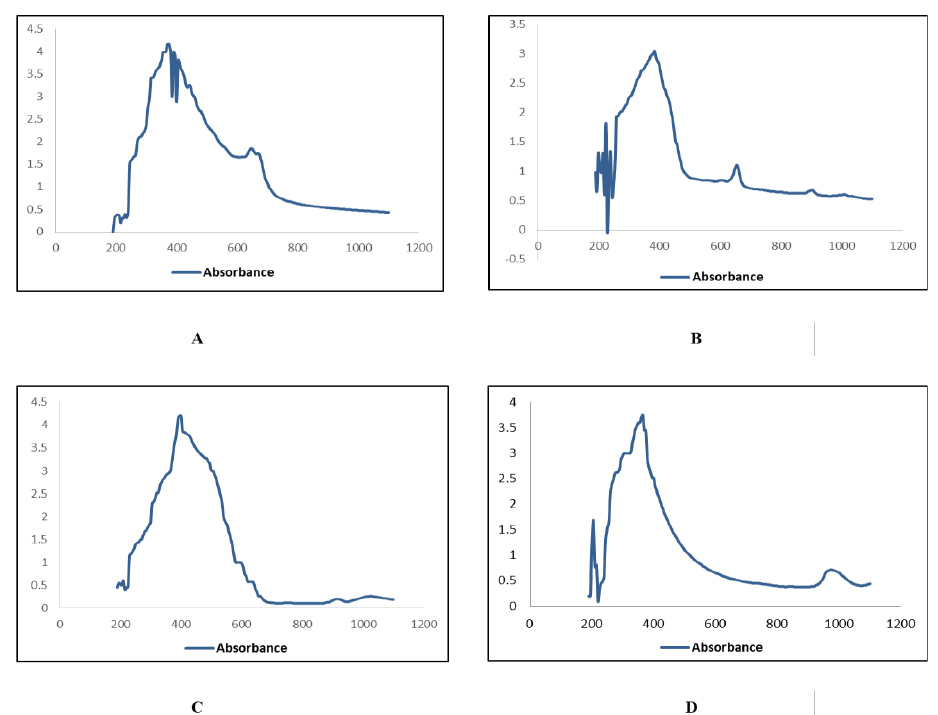
Figure 2. UV Visible absorption spectra of zinc oxide nanoparticles of leaves. ( A ) n_Hexane ( B ) Ethyl Acetate ( C ) Methanol ( D ) Aqueous.